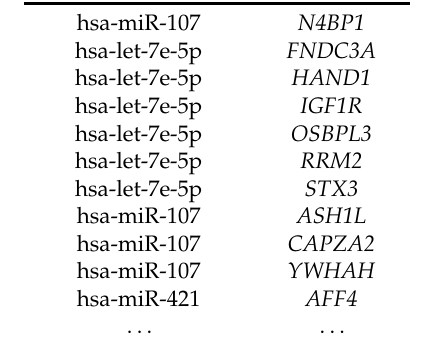
Table 2. miRmapper input. miRNA-gene interaction data frame, no headers.